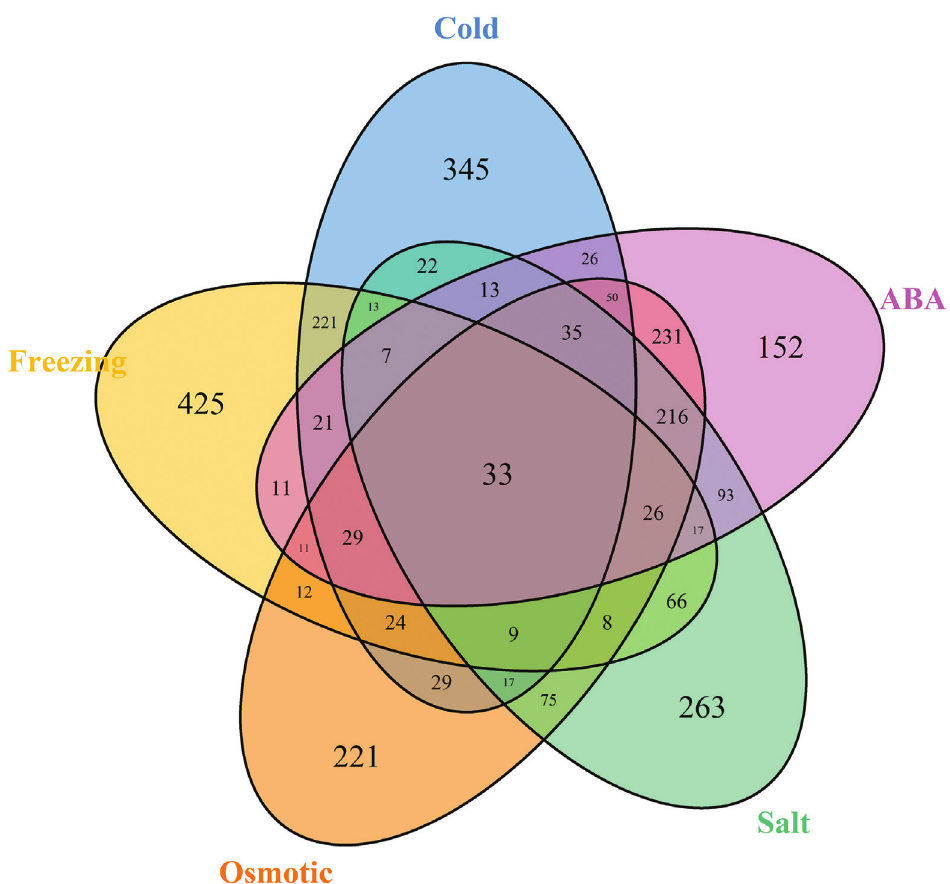
Figure 5 - Diagrammatic representation of the distributions of Medicago ruthenica genes that are differentially expressed in response to five abiotic stresses. The Venn diagram shows the overlap of DEGs in the responses to various abiotic stresses. The cold and freezing stress groups share more com- monly expressed genes, while the osmotic, salt and ABA stress groups probably contain other